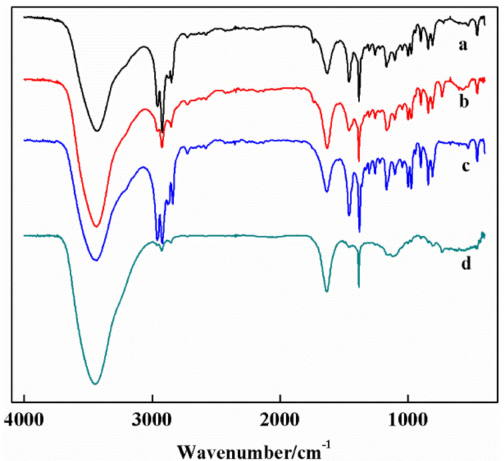
Figure 2. FT-IR analysis chart ( a ) PP; ( b ) GO; ( c ) PP/GO blend fiber; ( d ) PP/MAH/GO-3 composite fiber).